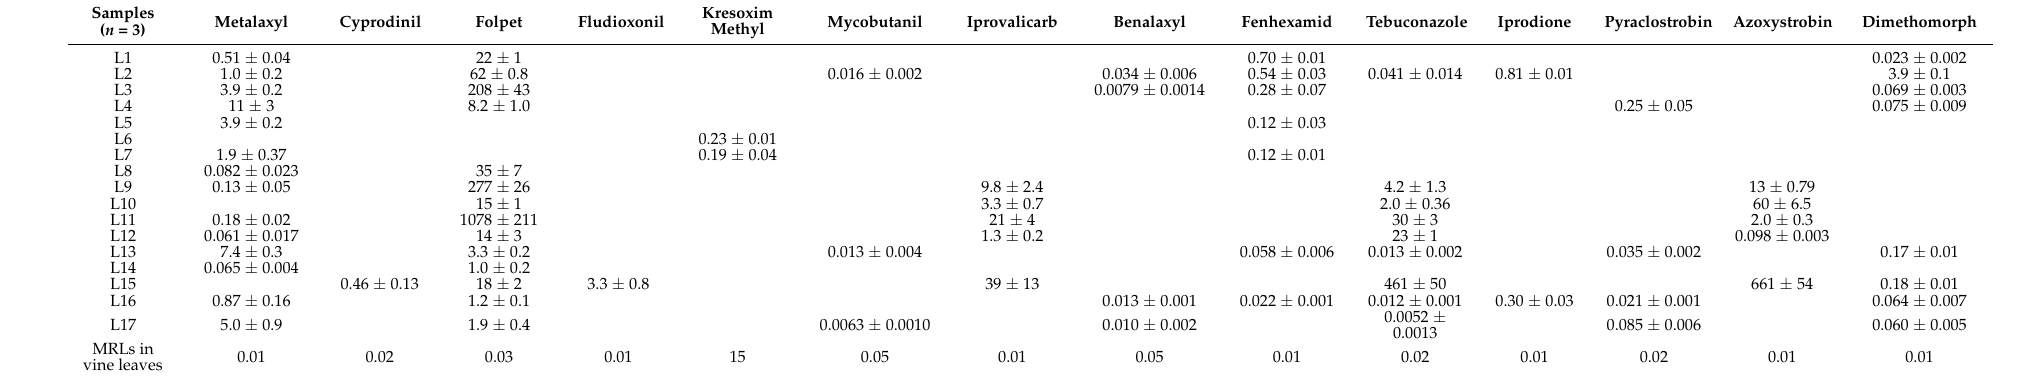
Table 3. Concentration ± standard deviation (SD) ( µ g g − 1 ) of the fungicides in vine leaves analyzed by